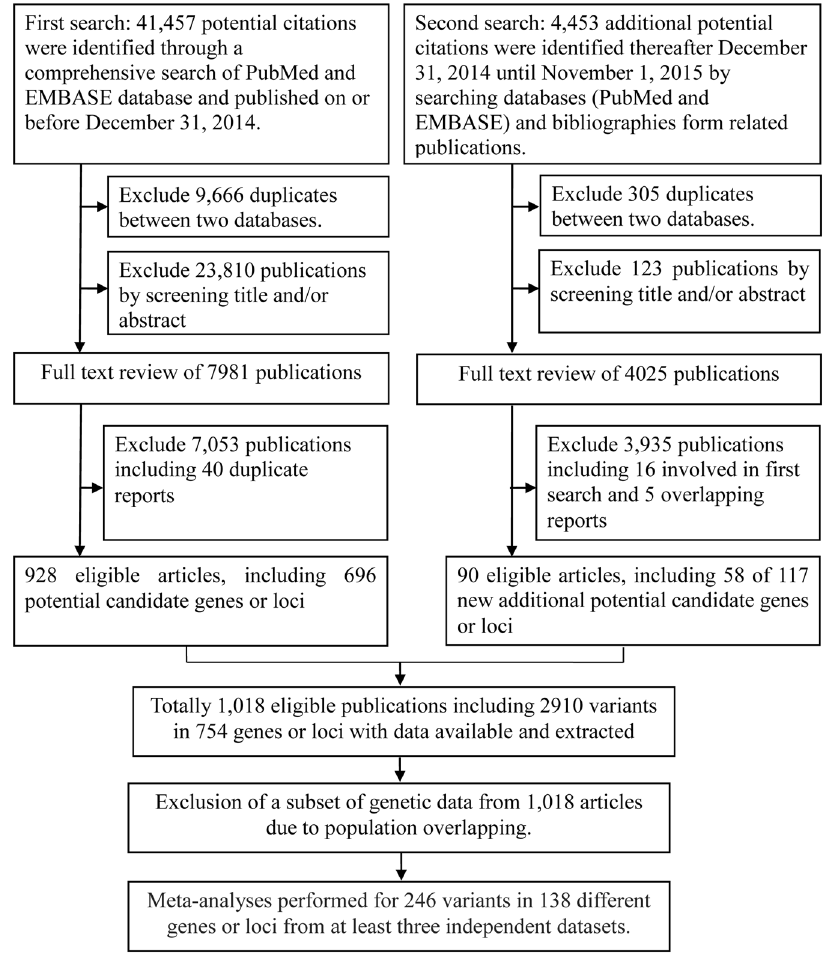
Figure 1. Flowchart of literature search and selection for meta-analyses for candidate-gene association studies of lung